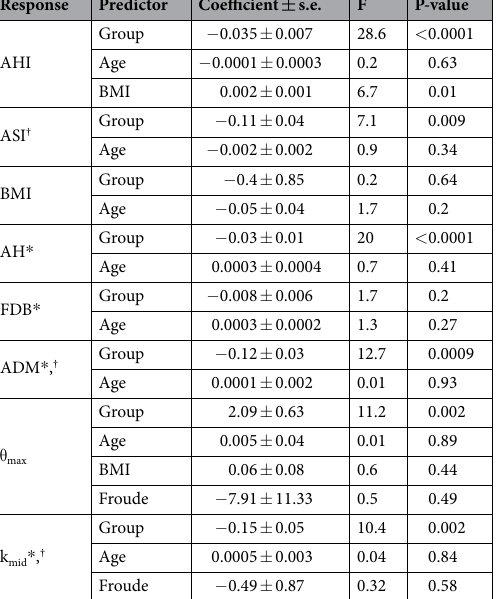
Table 2. General linear model coefficients, and results of ANOVA tests on model variance. Reference level for ‘Group’ is minimally-shod participants. * For general linear models, these variables were scaled by dividing by (body mass) 0.67 . † For general linear models, these variables were logged.